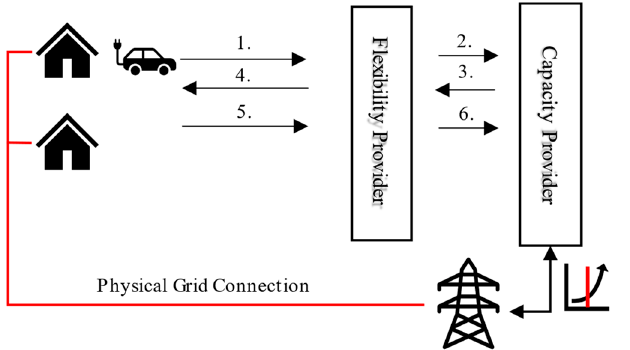
Figure 1. Simulation sequence of the developed simulation framework SmartDSO. The figure shows general simulation steps (1–6) and price communication between price-sensitive mobility demand and the grid fees depending on congestion calculated by the capacity provider.